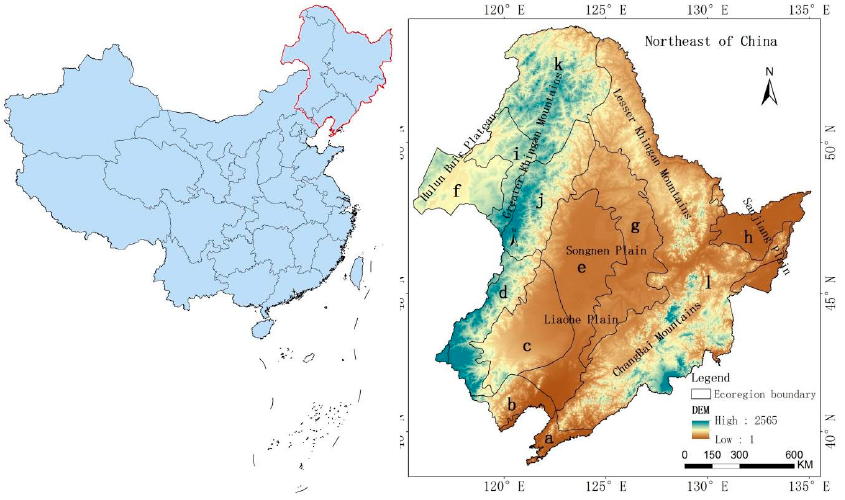
Figure 1. Location of the study area, Northeast China.